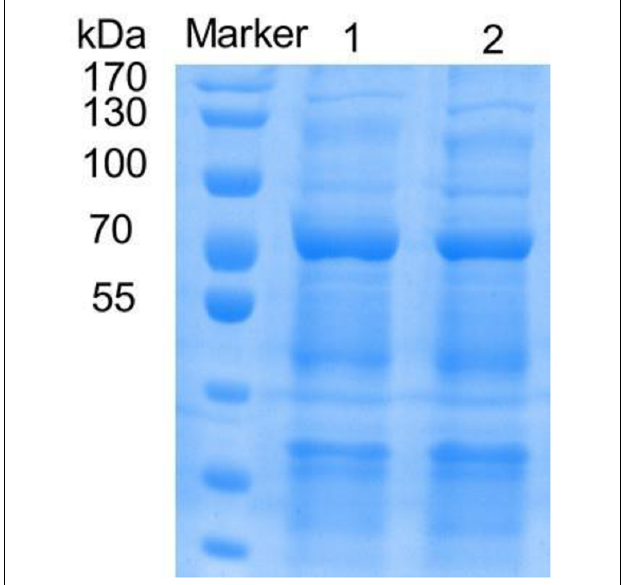
FIGURE 1 | SDS-PAGE of recombinant and mutanted laccase. M, TaKaRa; 1, recombinant laccase lac 1338; 2, Mutanted laccase.